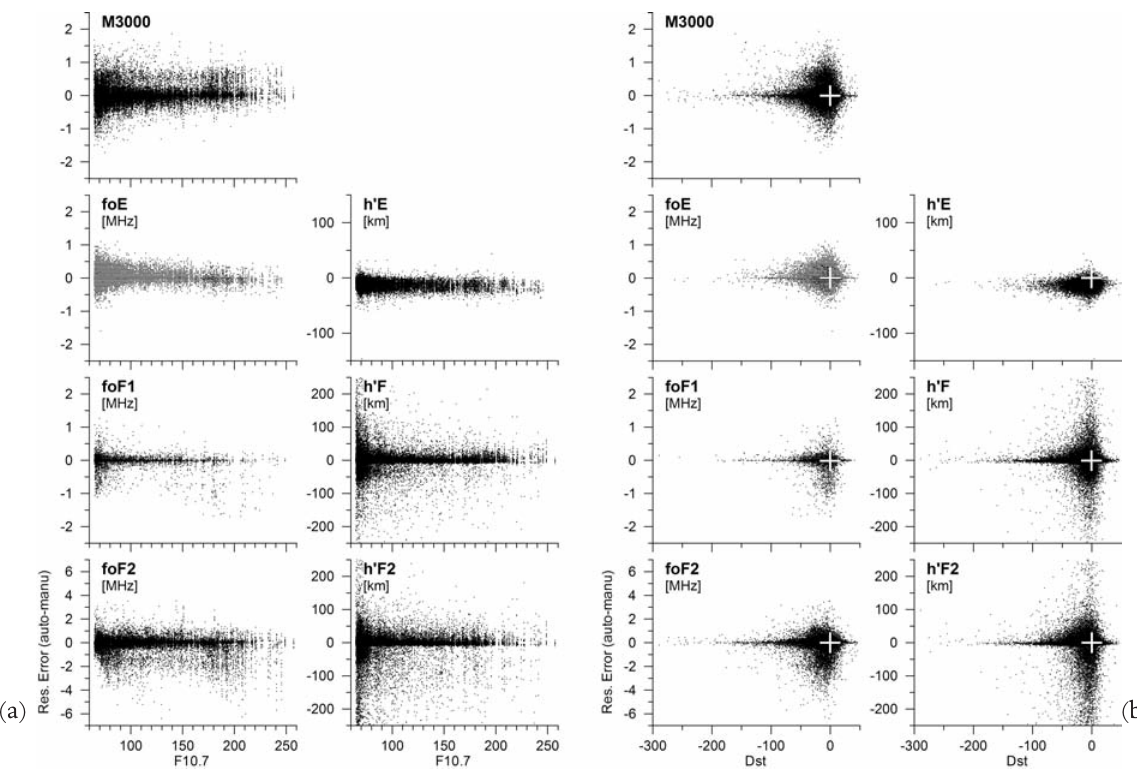
Figure 6. Comparison between automatically (auto) and manually (manu) scaled ionospheric characteristics during the period of 2002 to 2008. Scatter plots of the residual errors versus F10.7 [10-22 Wm-2Hz-1] (A) and the Dst [nT] (B)